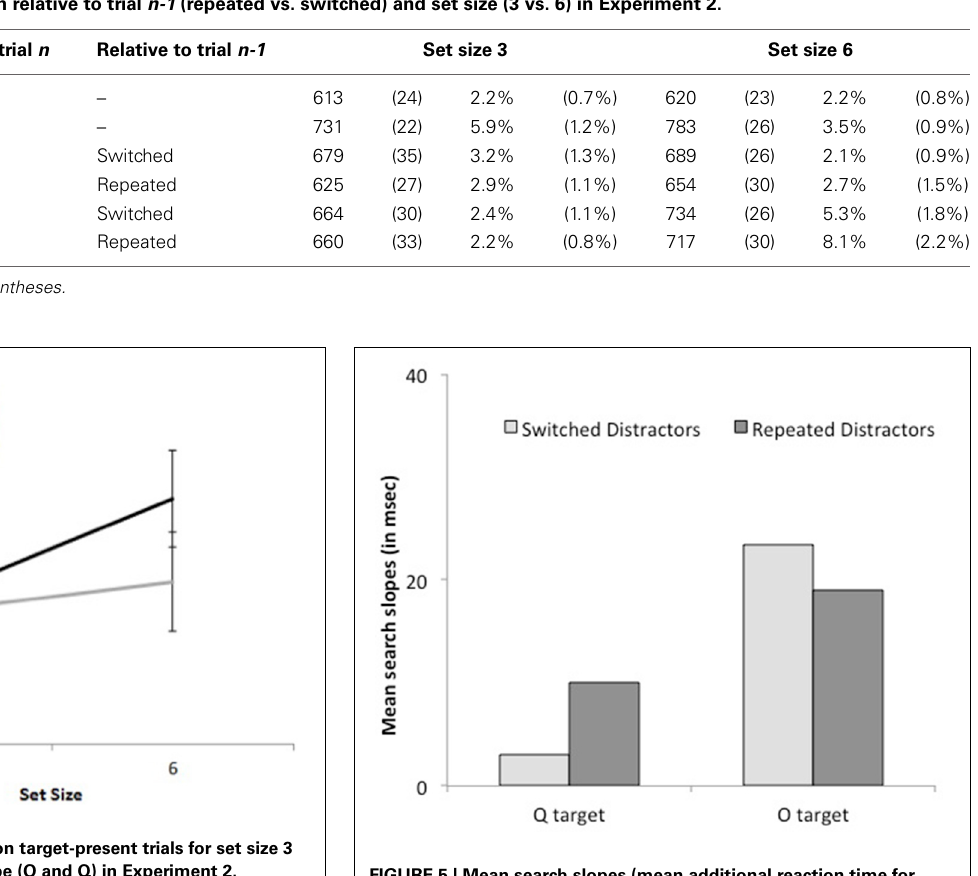
Table 2 | Mean reaction times (in milliseconds) and percentage of errors by conditions of target presence (present vs. absent), distractor on trial n (Q vs. O), feature repetition relative to trial n-1 (repeated vs. switched) and set size (3 vs. 6) in Experiment 2.